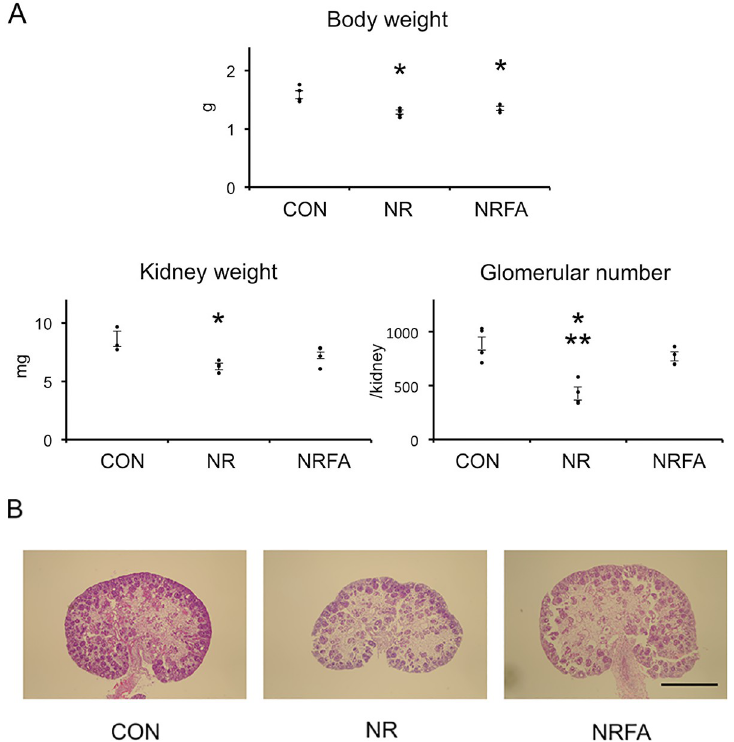
Fig 2. Effect of folic acid supplementation on the reduction in body weight, kidney weight, and glomerular number induced by maternal nutrient restriction at embryonic day 18. (A) After fetal weight was recorded, kidneys were isolated and weighed. They were then fixed, sectioned, and stained with hematoxylin and eosin (representative figure) or PAS (glomerular counting). Glomerular number was counted as described in Materials and Methods. The mean value (body weight and kidney weight) or one value (glomerular count) of each litter was used for statistical analysis (ANOVA followed by Tukey’s test). CON, controls; NR, offspring of nutrient-restricted mothers; NRFA, offspring of nutrient-restricted mothers supplemented with folic acid. n = 4 litters, n = 9–15 animals per litter. Dots indicate the mean value (body weight and kidney weight) or one value (glomerular number) of each litter. Bars represent ± SE. � , P < 0.05 vs CON; �� , P < 0.05 vs NRFA. (B) Representative images. Scale bar, 1